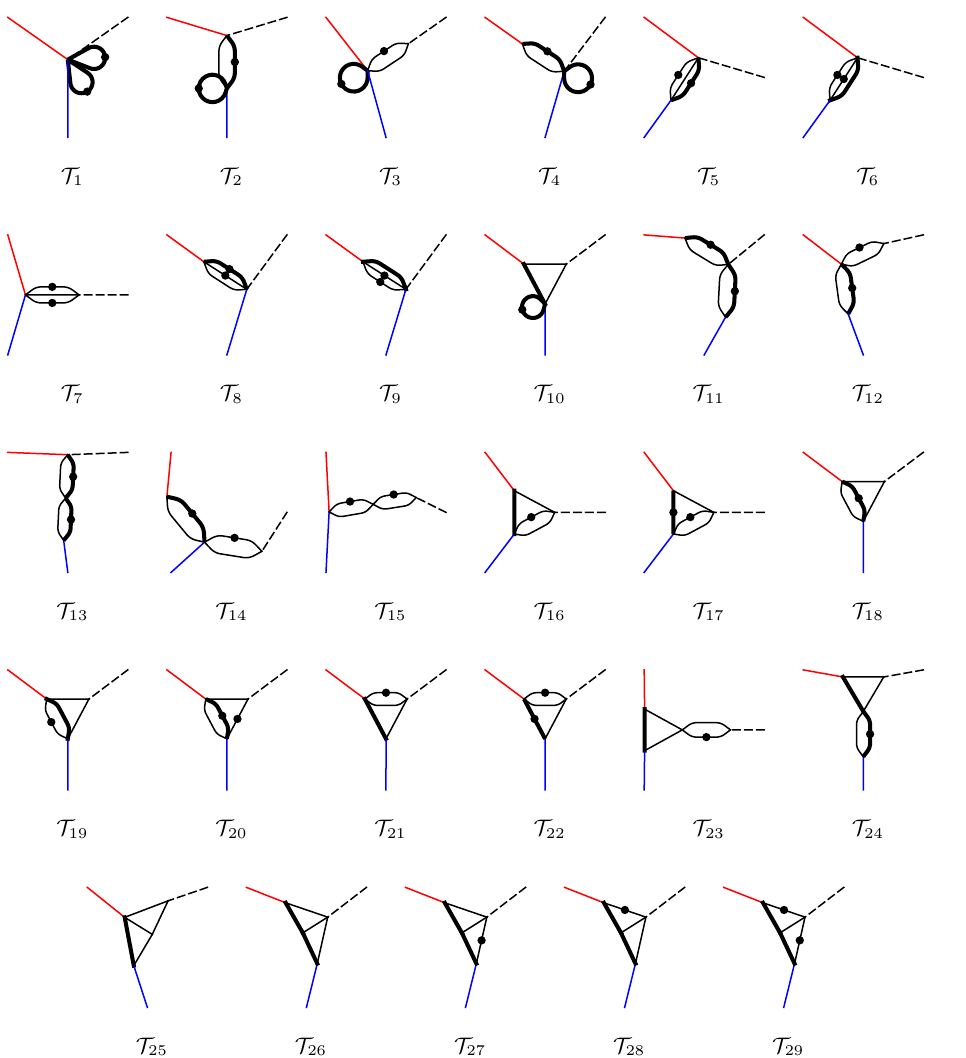
Figure 3. Two-loop MIs T for topologies (a)-(b). Graphical conventions are the same as in 1 ;:::; 29 (cid:12)gure 2. Dots indicate squared